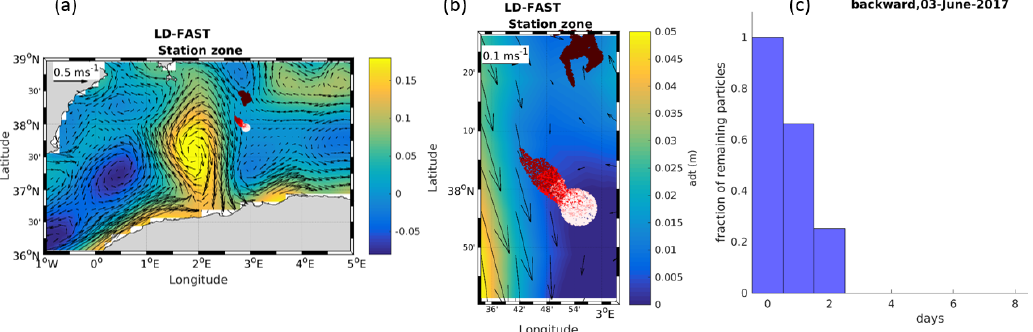
Figure 12. ARIANE particle initial positions (white) and after a backward integration of 1 (pink), 2 (light red), 3 (dark red) and 10d (black) for the FAST station on 3 June. (a) Large view; (b) zoomed view; (c) ratio of particles remaining in the initial zone as a function of the number of backward integration days.